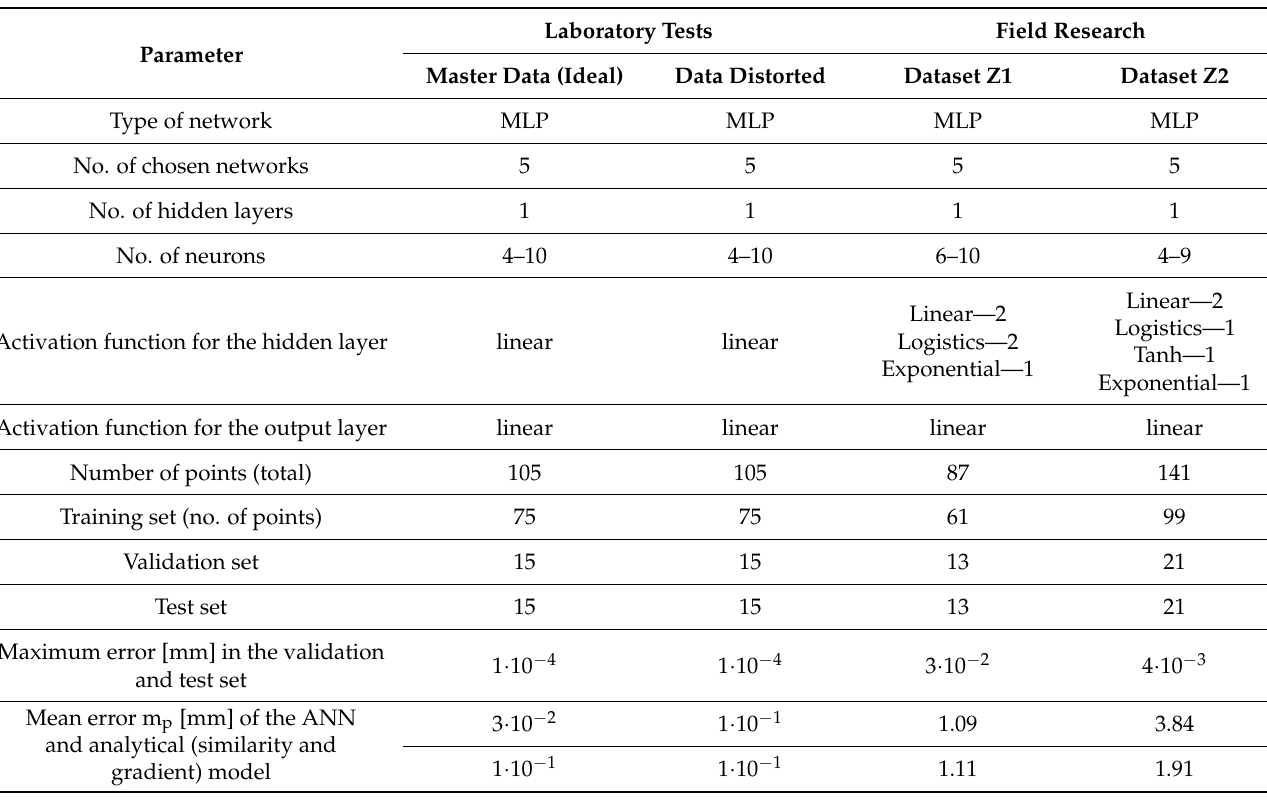
Table 4. Parameters of the ANNs used for laboratory and field